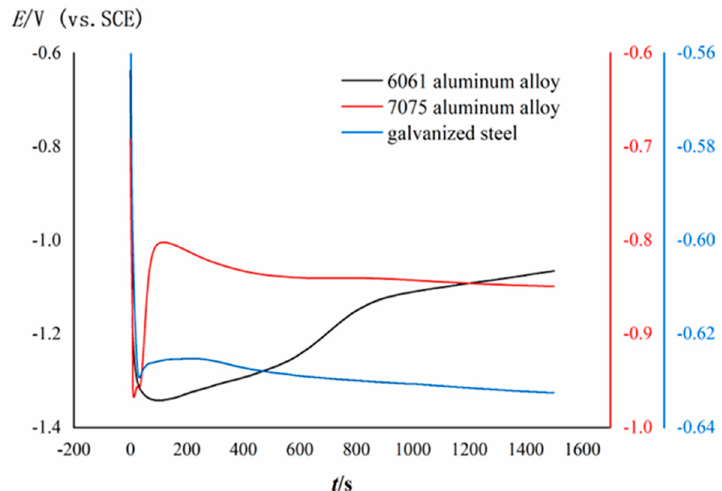
Figure 1. Open circuit potential during the formation of synchronous chemical conversion coatings of multi − metal.